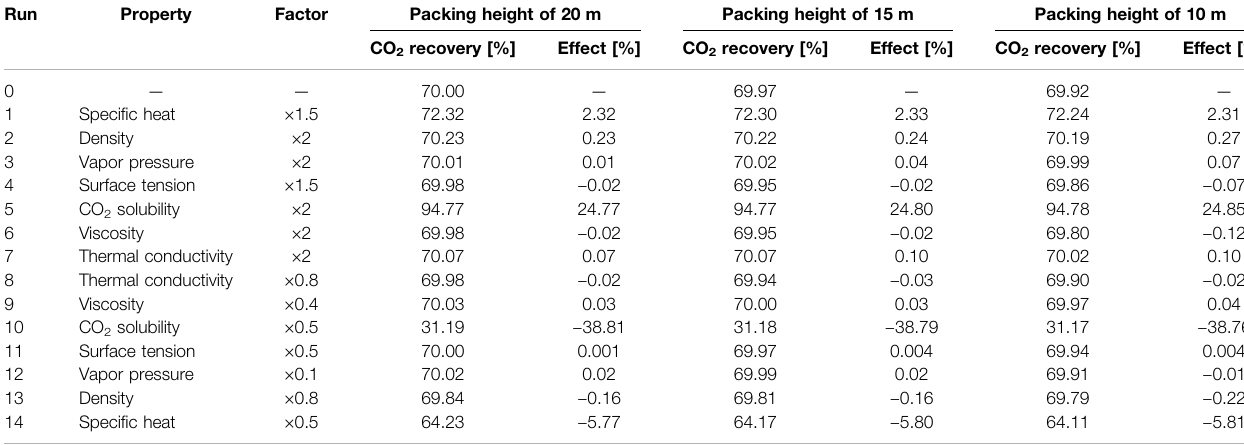
TABLE 5 | Sensitivity analysis of solvent properties with Billet and Schultes (1993) correlations (lean solvent fl ow rate of 3,483 kg/s). Run